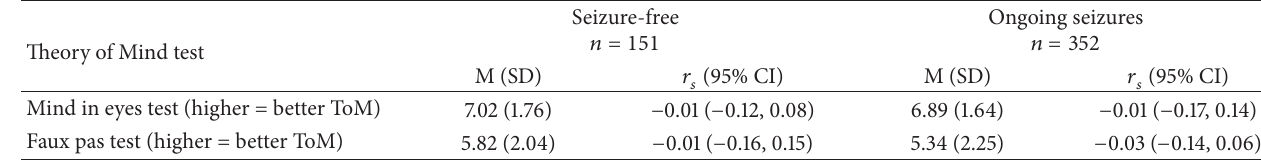
Seizure-free 𝑛 = 151